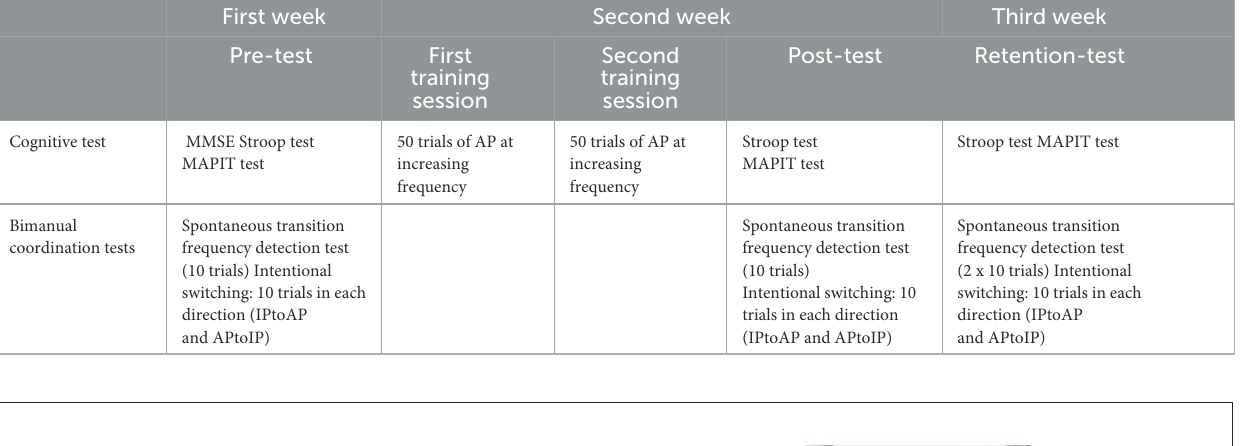
TABLE 1 Overview of the protocol.